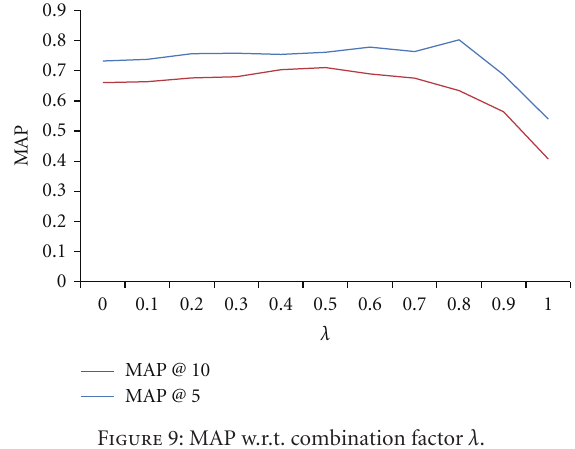
Figure 9: MAP w.r.t. combination factor λ